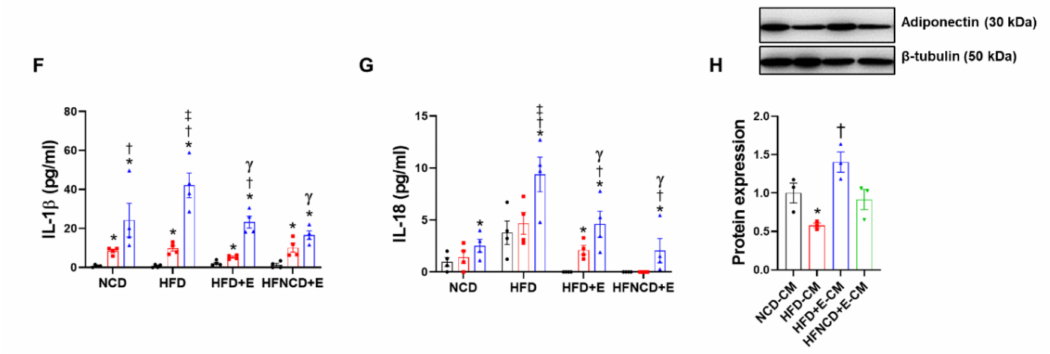
Figure 5. Exercise and diet attenuate HFD-induced NLRP3 inflammasome activation in BMDMs. ( A – D ) BMDMs isolated from experimental mice were treated with LPS (100 ng/mL) for 6 h and ATP (2 mM) in the last 30 min. Gene expression levels were measured using real-time PCR, and the quantifications were normalized to the 18S rRNA level for each target. ( E ) Representative Western blots and quantification of NLRP3 in BMDMs isolated from experimental mice. ( F , G ) IL-1 β and IL-18 were measured in the BMDM supernatants using ELISA. ( H ) Representative Western blots and quantification of adiponectin in 3T3-L1 adipocytes treated for 24 h with conditioned media obtained from BMDMs isolated from each group. The protein levels were normalized to β -tubulin. Values are presented as mean ± SEM. * p < 0.05 compared with control, † p < 0.05 compared with LPS, ‡ p < 0.05 compared with NCD LPS+ATP, γ p < 0.05 compared with HFD